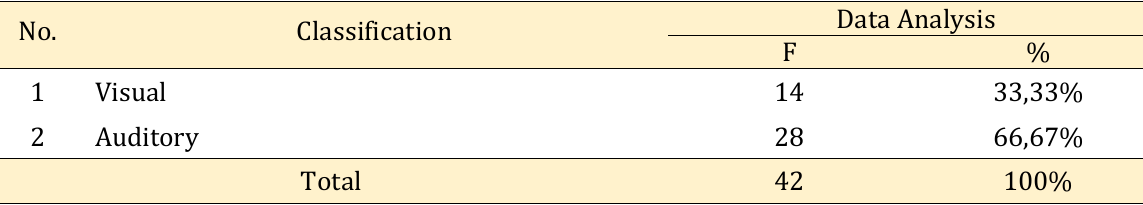
Table 2. The Students’ Learning